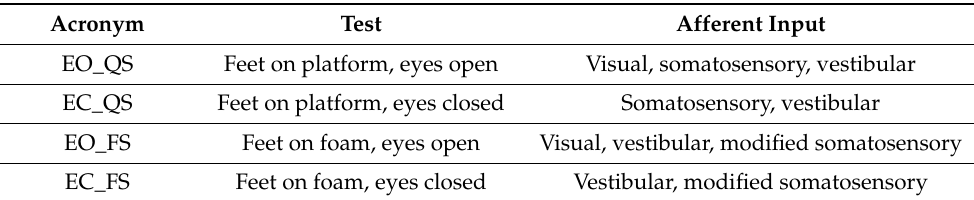
Table 1. Modified afferent inputs according to the different tests (adapted from Molloy et al., 2003 [36]).